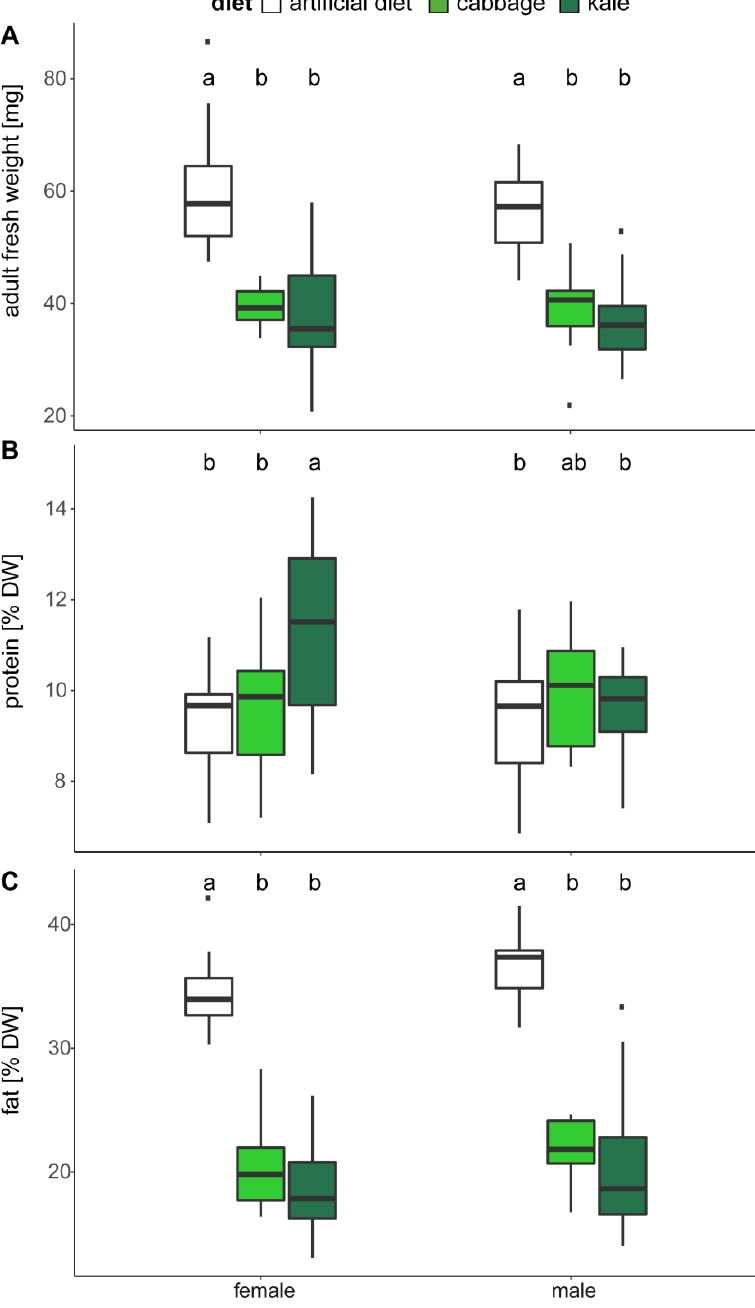
Figure 4. Adult body composition after eclosion. ( A ) Adult fresh weight is strongly affected by the larval diet ( p (diet) < 0.001, p (gender) = 0.286, p (diet×gender) = 0.752). ( B ) The amount of protein (per dry weight) is differentially affected by diet for females and males ( p (diet) = 0.002, p (gender) = 0.033, p (diet×gender) = 0.008). ( C ) The amount of fat (per dry weight) is mainly affected by larval diet ( p (diet) < 0.001, p (gender) = 0.041, p (diet×gender) = 0.885). Mean, standard deviation and statistical details are in Table S4. Statistical differences were assessed using nested ANOVA with mixed effect model, letters denote statistical differences at the p = 0.05 level tested with Tukey posthoc test; ▪ indicate outliers in in the box-and-whiskers plots.